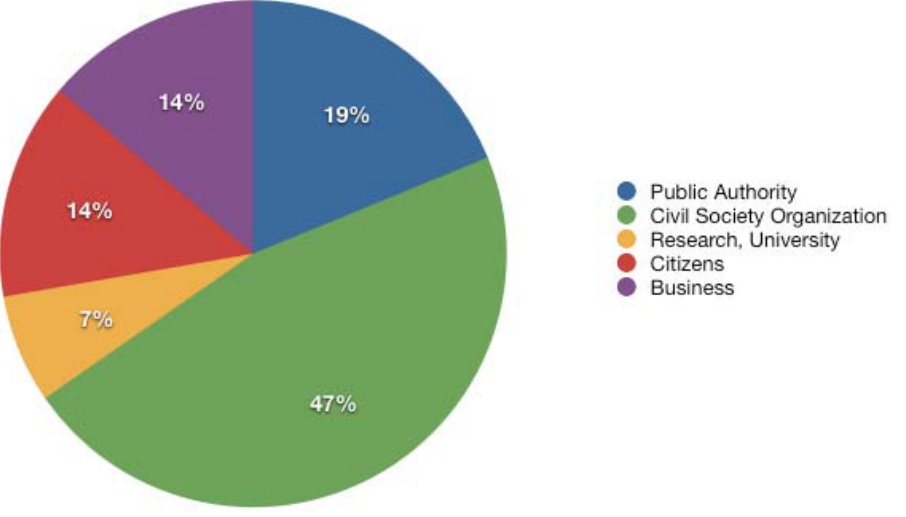
Figure 2. Origin of the contributions to the Commission consultations for the months September 2008 and March 2009 (Conseil Economique, Pour une participation active de la société civile aux consultations publiques européennes, 2009, p.